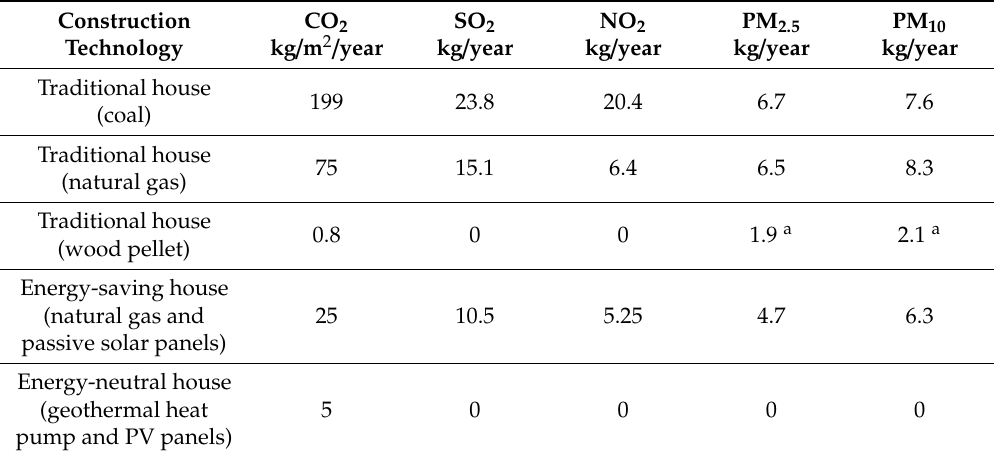
Table 4. Annual emissions for single-family rural house construction